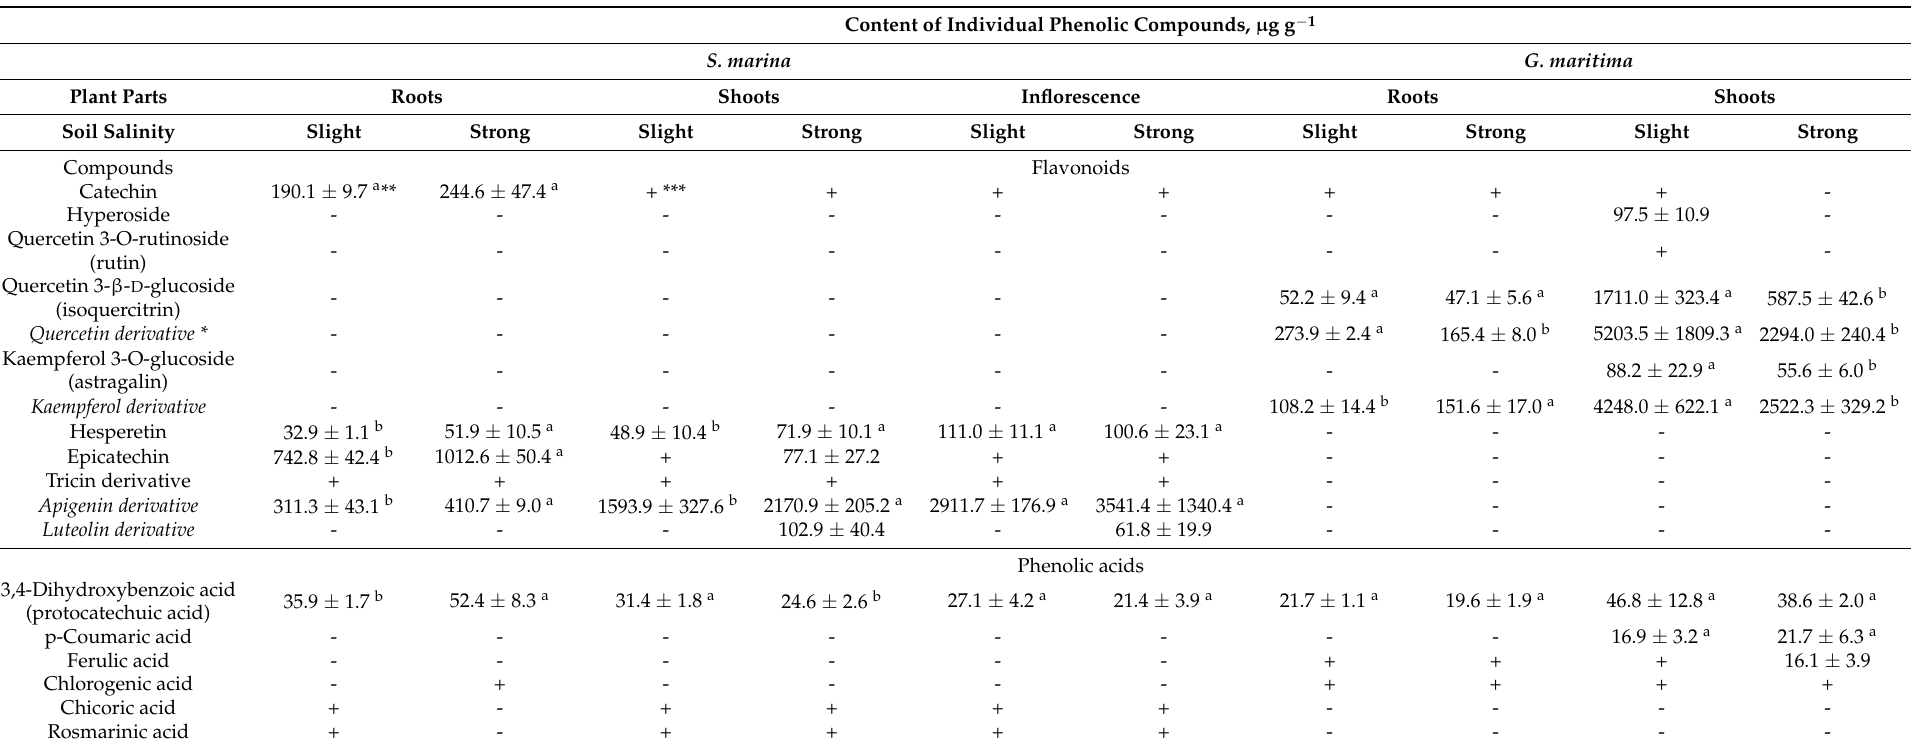
Table 2. Content of flavonoids and phenolic acids in different parts of the studied plants of S. marina and G. maritima at different levels of soil